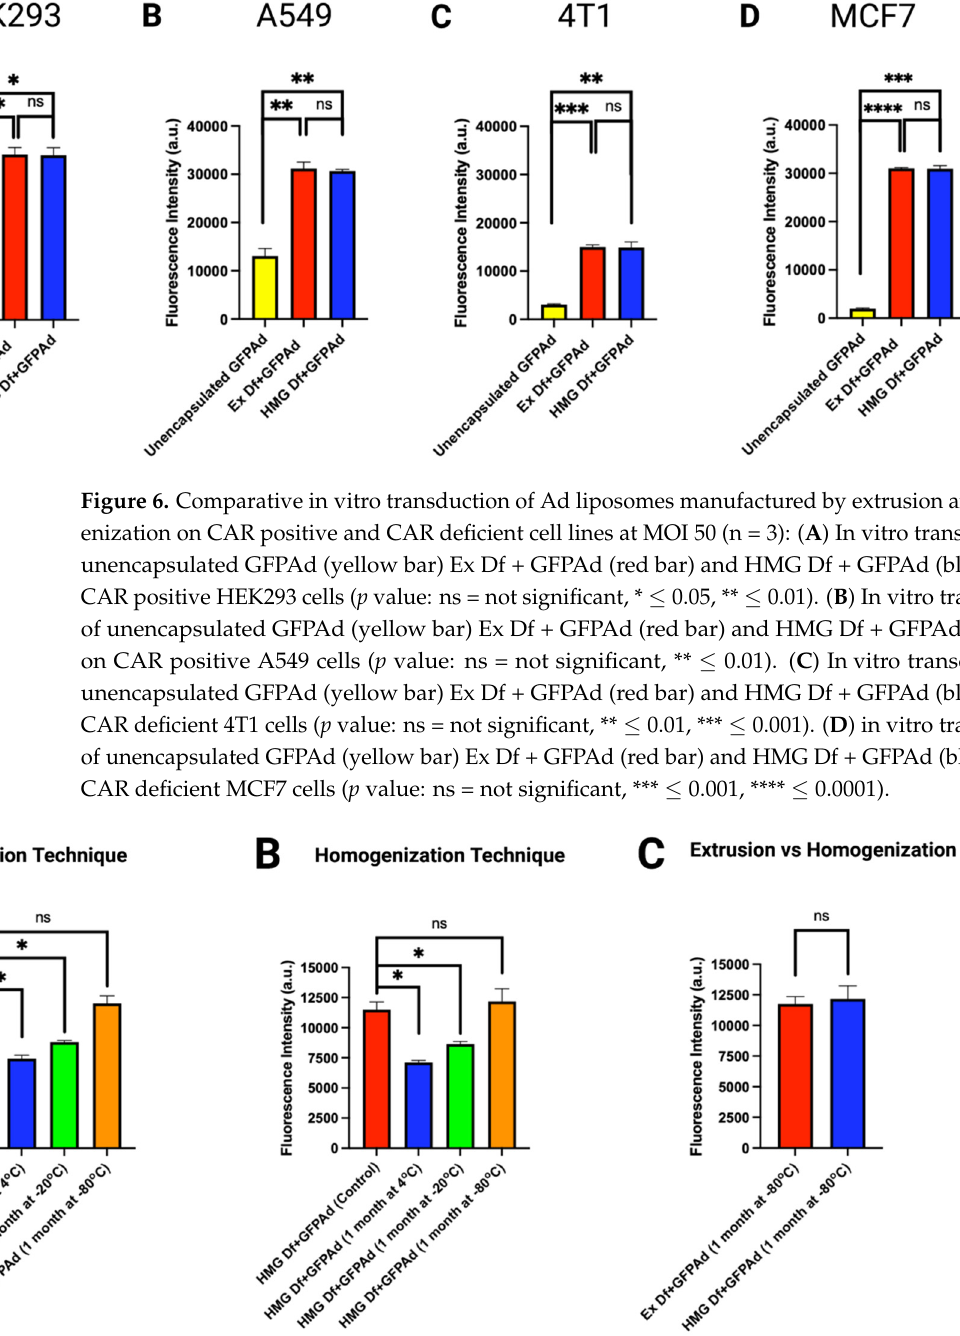
Figure 7. Comparative in vitro transduction of storage stability samples of Ad liposomes manufac- tured by extrusion and homogenization techniques on CT26 cells at MOI 50 (n = 3): ( A ) In vitro transduction of Ex Df + GFPAd manufactured using 1 month old Ex Df stored at 4°C (blue bar), − 20°C (green bar), and − 80°C (orange bar), compared with freshly prepared Ex Df + GFPAd (red bar - control sample) ( p value: ns = not significant, * ≤ 0.05). ( B ) In vitro transduction of HMG Df + GFPAd manufactured using 1 month old HMG Df stored at 4°C (blue bar), − 20°C (green bar), and − 80°C (orange bar), compared with freshly prepared HMG Df + GFPAd (red bar - control sample) ( p value: ns = not significant, * ≤ 0.05). ( C ) Comparative in vitro transduction of Ex Df + GFPAd (red bar) and HMG Df + GFPAd (blue bar) at MOI 50–manufactured using 1 month old aged Df stored at − 80°C ( p value: ns = not significant). Note: Figure 7C is drawn using the data sets taken from Figure 7A,B.